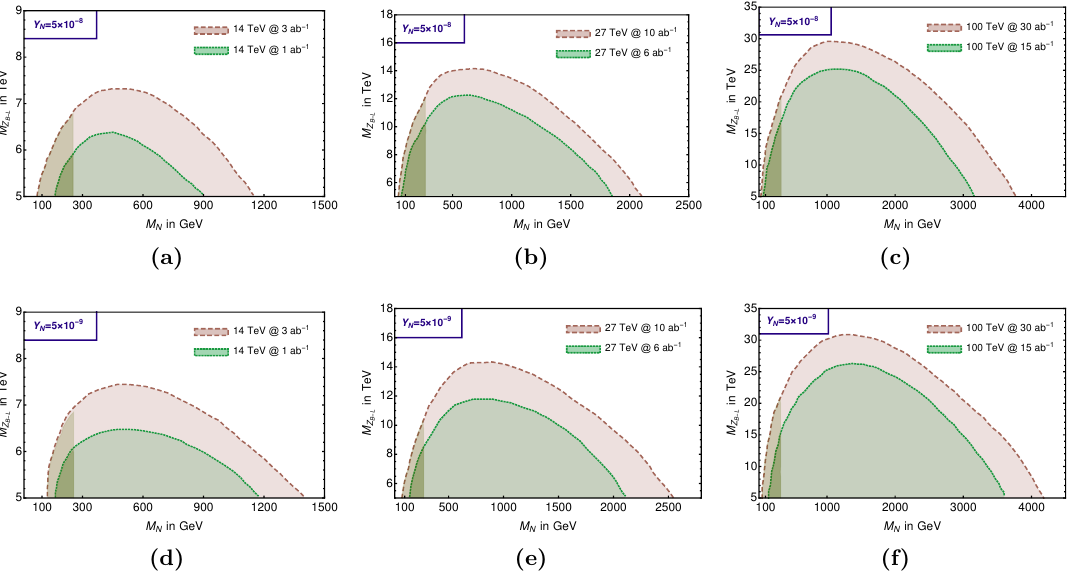
Figure 12. Limits obtained via the displaced decays of RHNs to 2 ‘ + 2 j final state (dark shaded region), 2 ‘ + 4 j final state (light shaded region) and it is presented in M 95% CL. The first and second panel present the probable regions for the Yukawa couplings 5 × 10 − 8 and 5 × 10 − 9 , respectively. The shaded regions can be probed at any of the detectors CMS, ATLAS and MATHUSLA for 14 TeV (a, d), 27 TeV (b, e) centre of mass energies, and at either of the